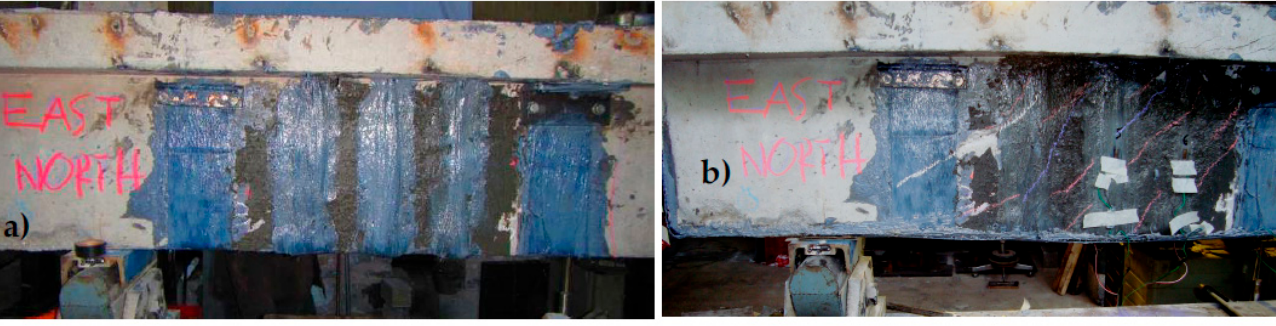
Figure 20. Comparison of the measured response between the prototype RC Virgin T-beam and this T-beam having been retrofitted with the 1 st and 2nd st rengthening schemes . ( a ) Shear force versus the deflection at mid-span. ( b ) Bending mo- ment versus the deflection at mid-span.